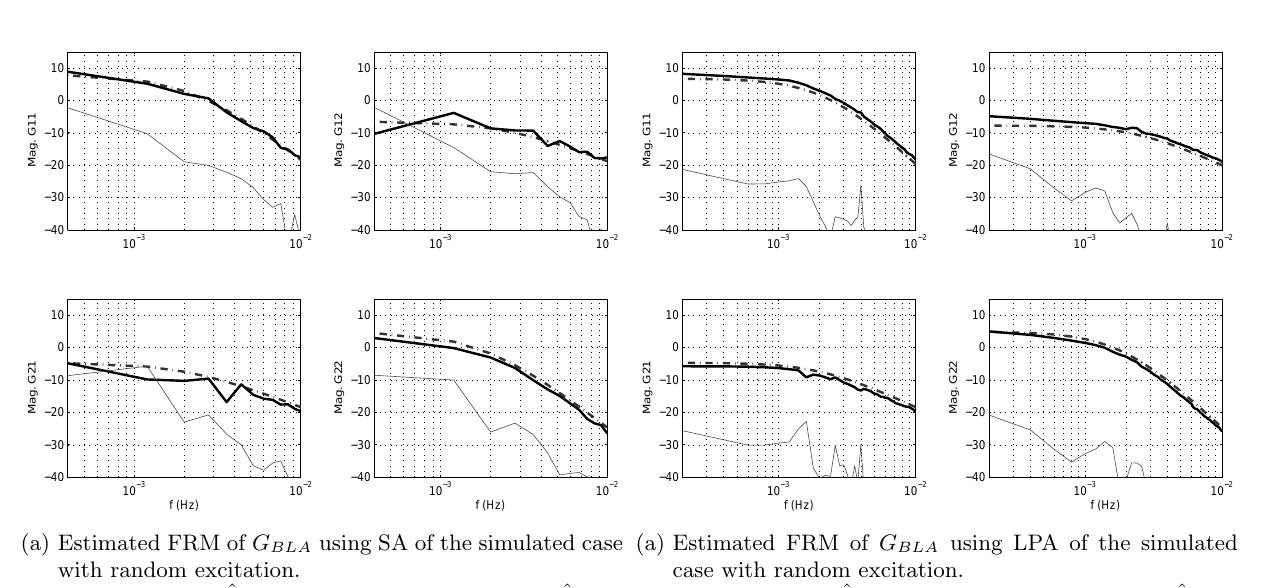
(a) Estimated FRM of G BLA using SA of the simulated case with random excitation. Black: FRM of ˆ G BLA . light Gray: Variances of ˆ G BLA . dark Gray (- · ): FRM of G lin .